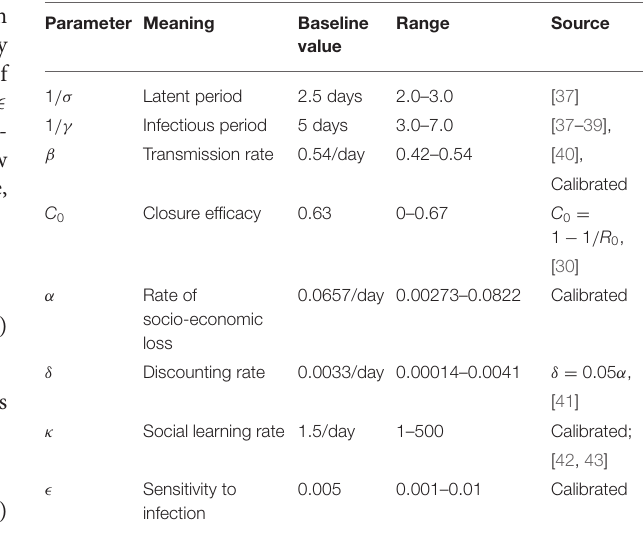
TABLE 1 | Parameter values, baseline values, and literature